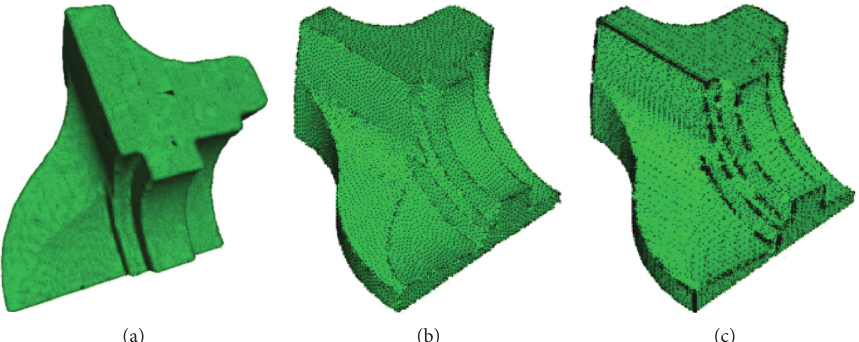
Figure 8: Simplification results of the Fandisk model (triangulated); the original number of points is 103,570. (a) Simplified using the novel method with parameters of cluster size and deleted cluster number (2590, 310) and (9759). (b) Simplified using Shi et al. method [16] with parameters of space interval and normal vector deviation threshold as (0.076, 0.13) and (9682). (c) Simplified using the 3D Grid method [39] with parameters of space interval and standard normal vector deviation as (0.0696, 0.41) and